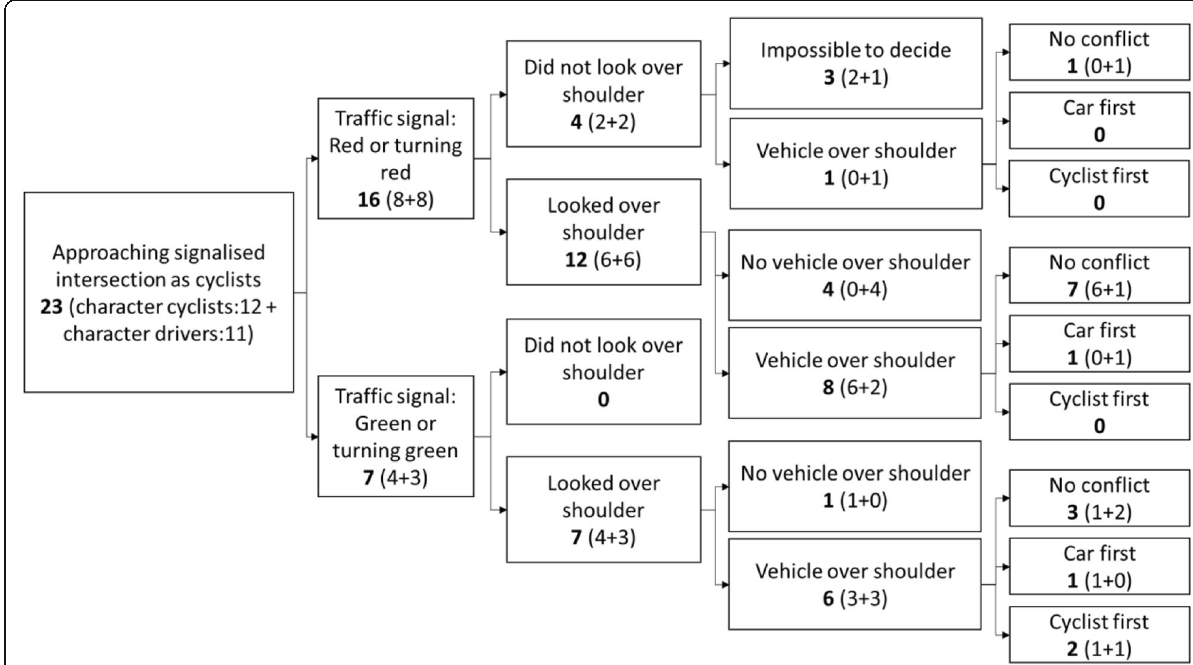
Fig. 5 Looking over shoulder at green traffic signal before cycling straight on at the signalised intersection, depending on traffic signal on approach to the intersection and whether there was any vehicle over shoulder. Results in total (number of outcomes for character cyclists + number of outcomes for character